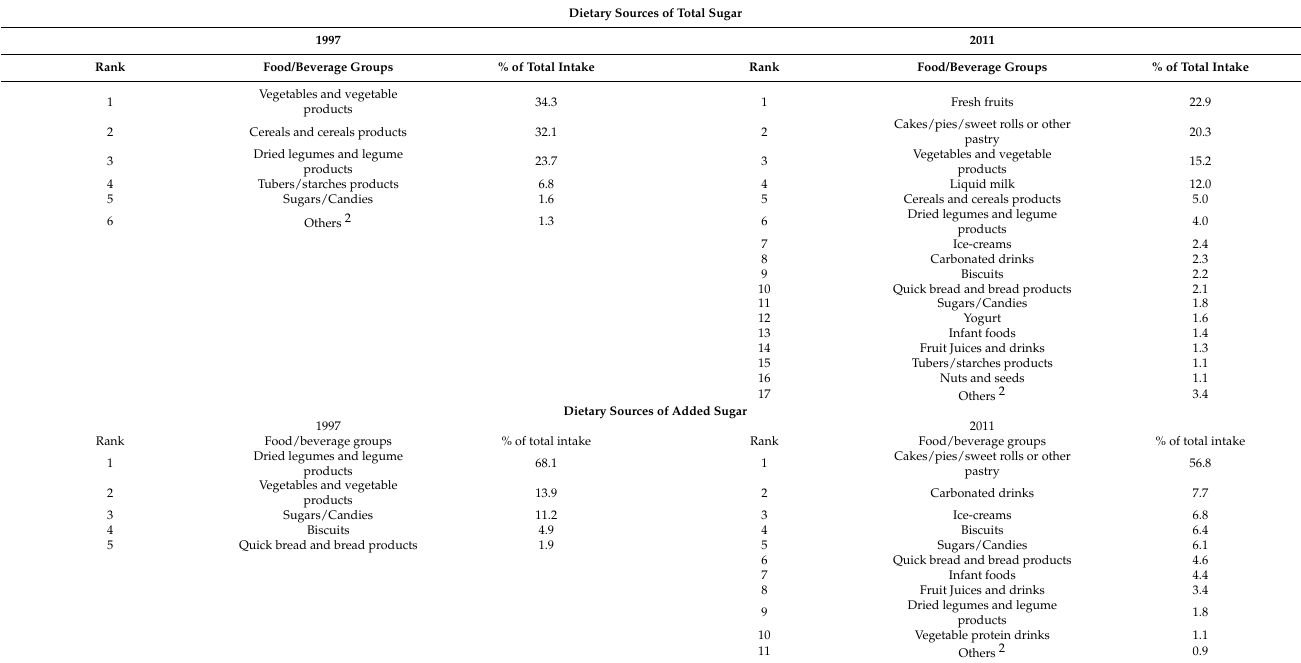
Table 4. Dietary sources of total and added sugars among Chinese children and adolescents, CHNS 1 1997 and